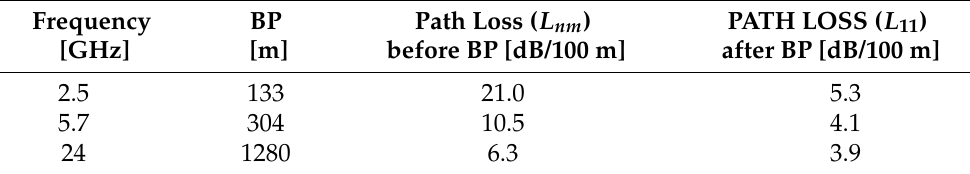
Table 5. Calculation of BP and path losses for different frequencies in concrete tunnel of 4 m